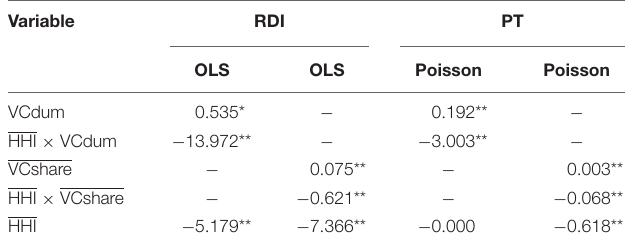
TABLE 5 | Impact of venture capital on technological innovation of enterprises. Variable